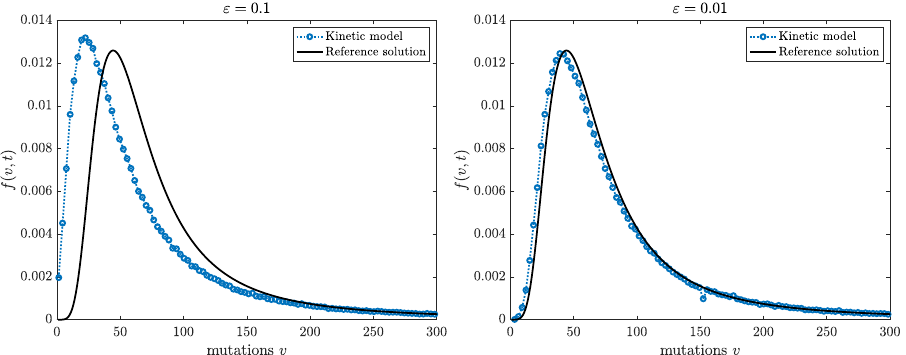
Figure 2. Lea–Coulson case. Distribution of mutant cells at T f = 6.7 with β 1 = 3 and β 2 = 2.8 for ε = 0.1 ( left ) and ε = 0.01 ( right ) in the kinetic model (18) under scaling (33), with L ( v ) , a Poisson process of mean β v . The reference solution is computed using Lemma 2 in [18] and numerical